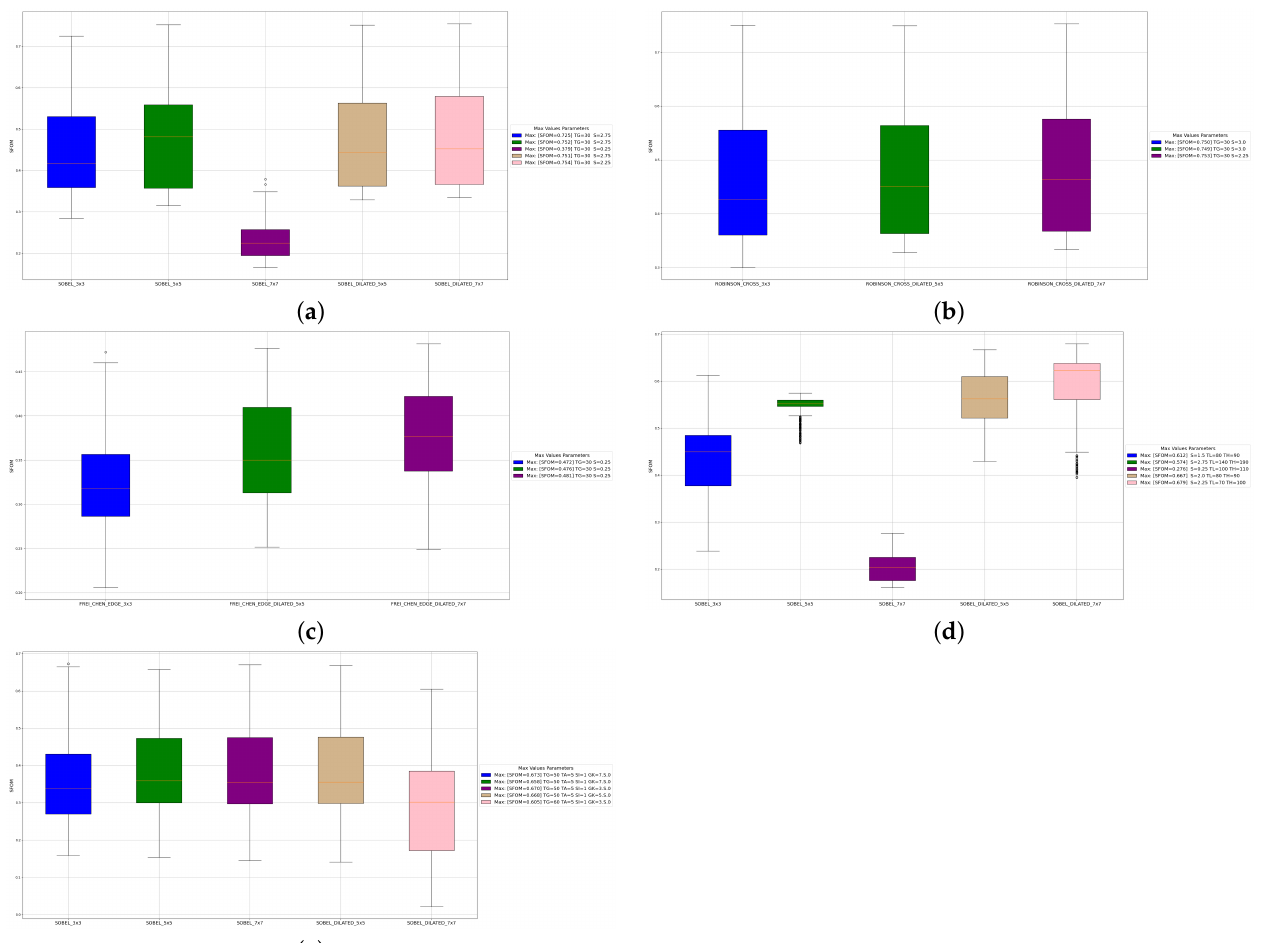
Figure 8. Best results on the synthetic dataset for classic, extended and dilated using different parameters for: ( a ) first-order derivative orthogonal gradient operators; ( b ) first-order derivative compass gradient operators; ( c ) Frei–Chen edge operator; ( d ) Canny operator; ( e ) ED edge